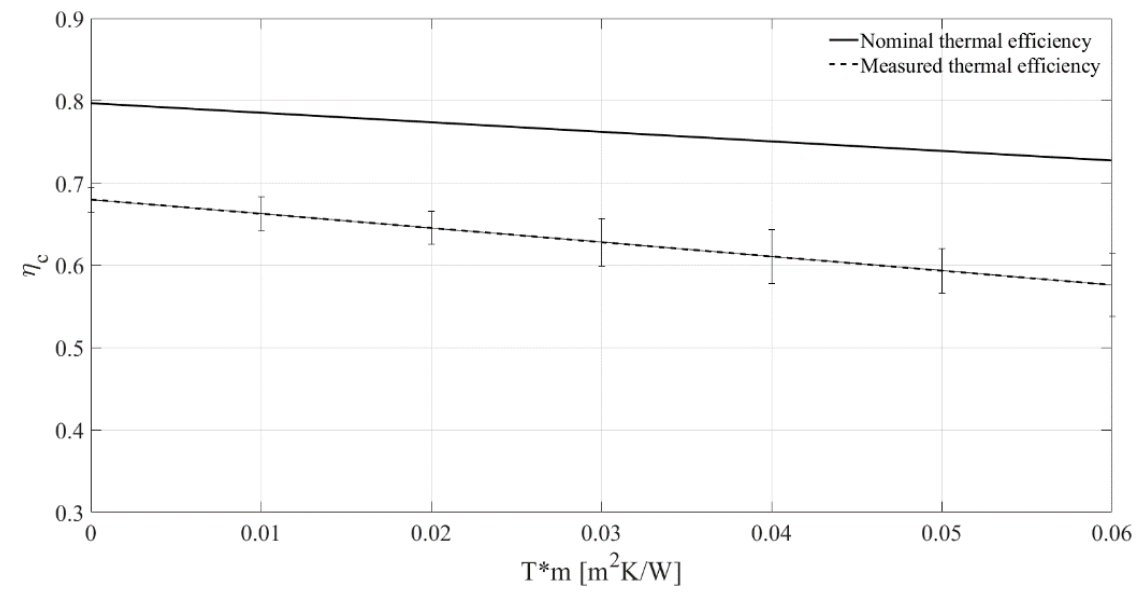
Figure 19. Characteristics of the heat capacity of the collector tested, and the nominal ones based on the data sheet.